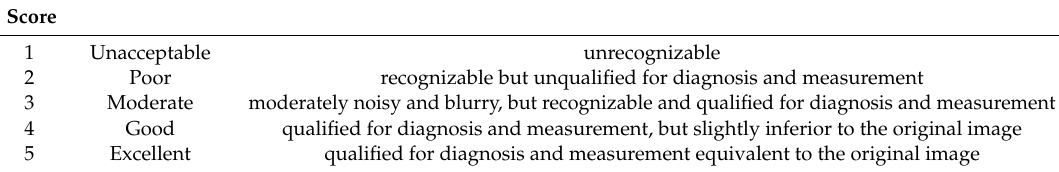
Table 3. Score criteria for the evaluation of abnormal